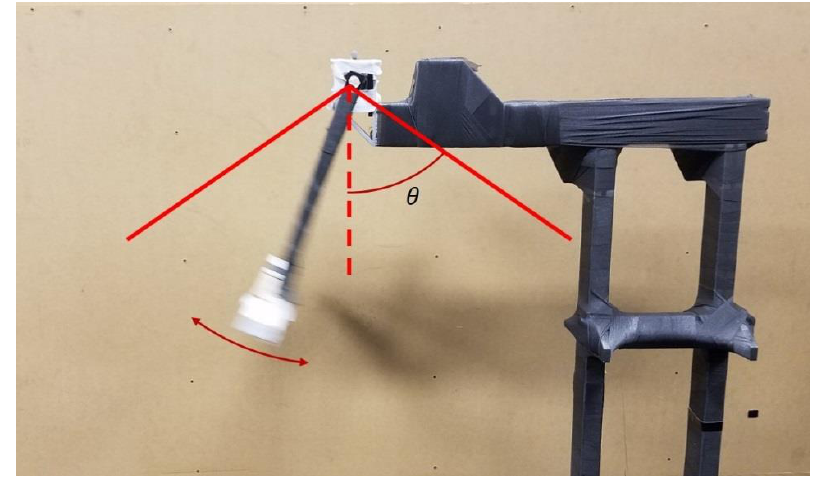
Figure 3. The range of motion achieved by the pendulum articulation. The release height ( θ ) was approximately 60° for all trials and would swing through nearly 120°.